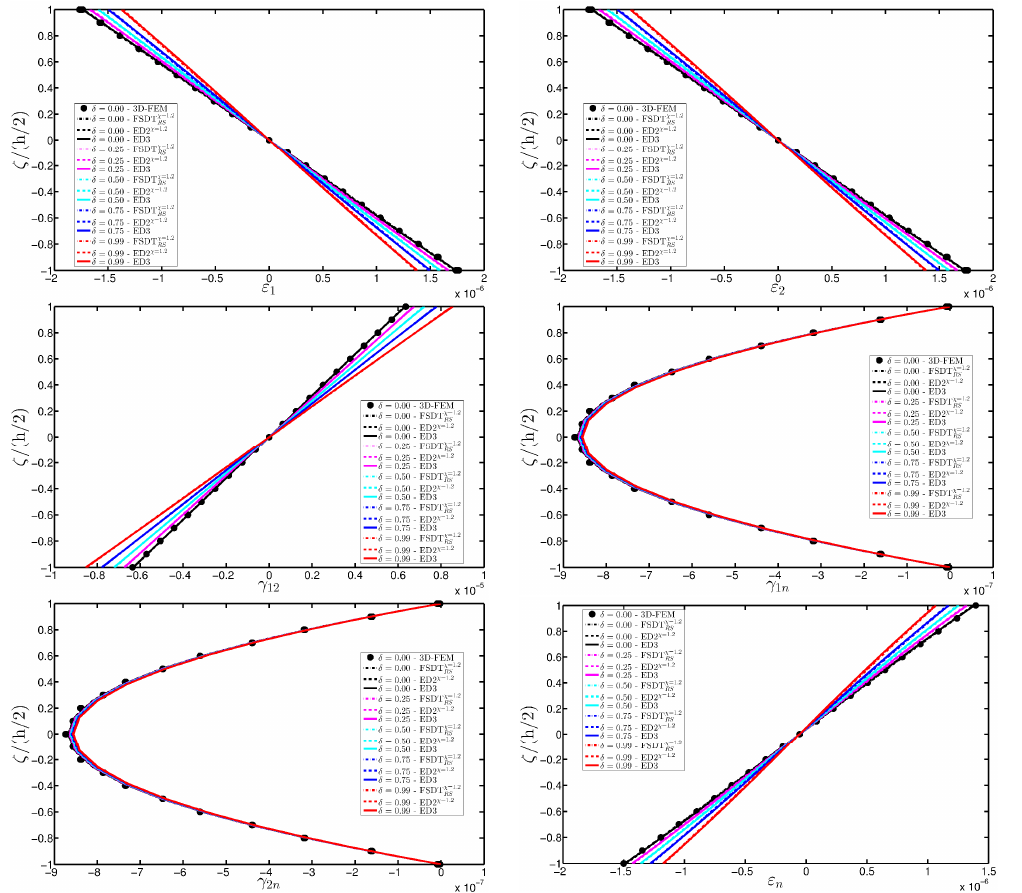
Figure 7. Through-the-thickness profiles of strain components for the CCCC isotropic square plate computed at the point A for different HSDTs. The effect of the damage is investigated by varying the parameters of the function Gau-2.